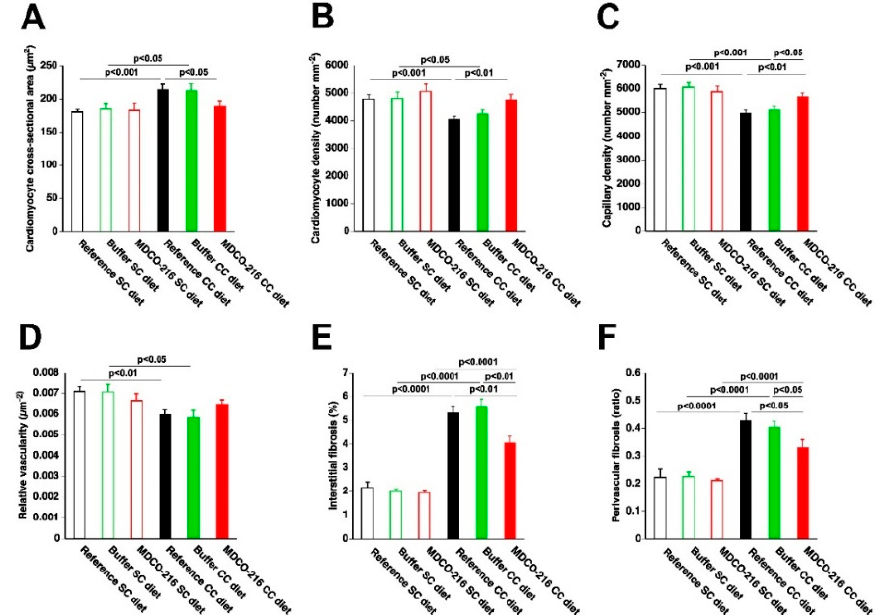
Figure 5. Quantification of histological and immunohistochemical parameters in the myocardium of C57BL/6 SC diet mice and C57BL/6 CC diet mice. Bar graphs showing the cardiomyocyte cross-sectional area ( A ), cardiomyocyte density ( B ), capillary density ( C ), relative vascularity ( D ), interstitial fibrosis( E ), and perivascular fibrosis ( F ) in reference SC diet mice ( n = 21), buffer SC diet mice ( n = 12), MDCO-216 SC diet mice ( n = 12), reference CC diet mice ( n = 30), buffer CC diet mice ( n = 14), and MDCO-216 CC diet mice ( n = 17) at 38 weeks (reference mice) and at 40 weeks (buffer mice and MDCO-216 mice). The CC diet was initiated at 12 weeks of age. SC diet mice and CC diet mice are indicated by open bars and closed bars, respectively. All data represent means ± SEM.